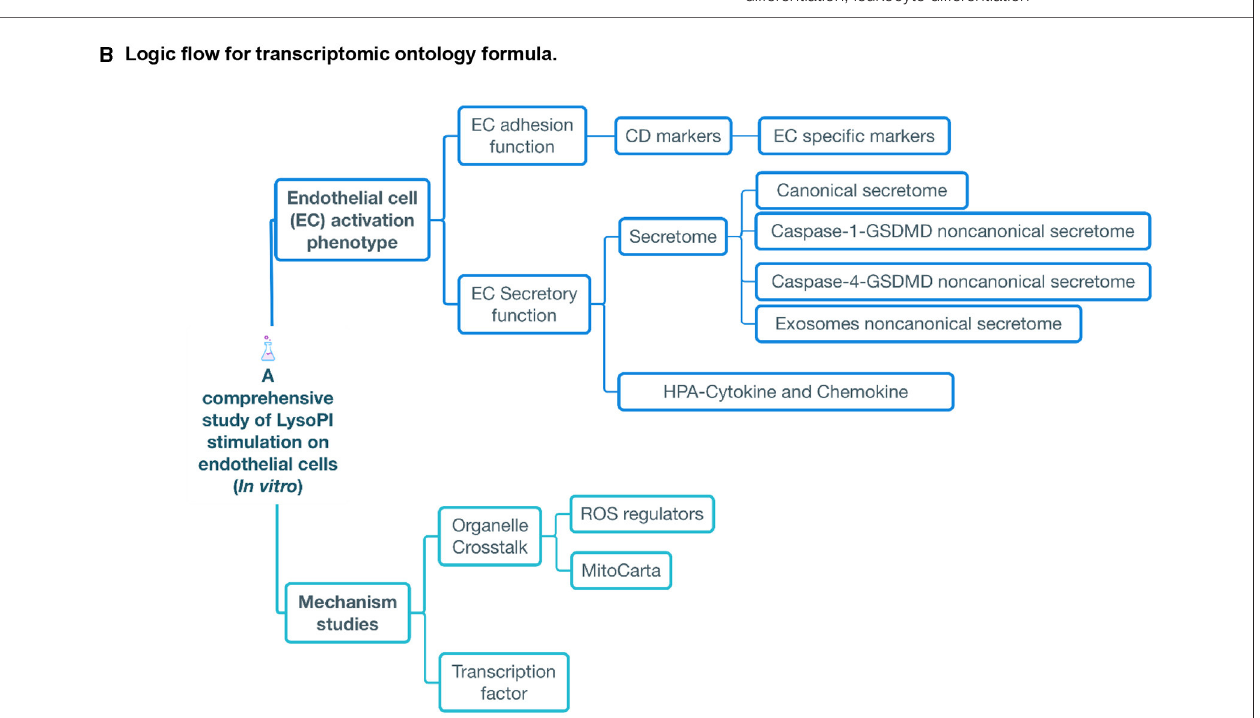
Frontiers in Cardiovascular Medicine |